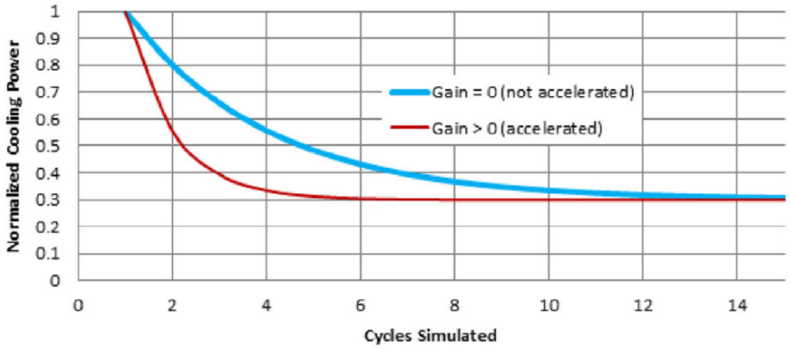
Figure 24. Observation of the influence of the convergence acceleration on the model output [83]. The convergence appears when the curves reach a set value.